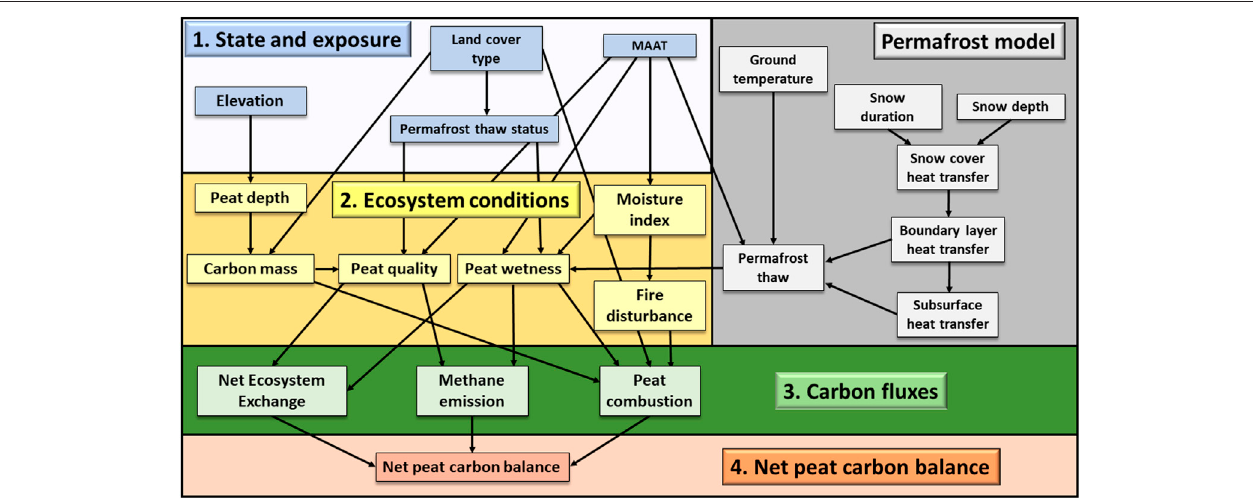
FIGURE 2 | General structure of in fl uence diagram of Bayesian belief network framework for the study area in the southern Hudson Bay Lowlands under current climate. Arrows connect parent nodes to child nodes and black bars indicate state (terminal parent nodes) or probability of in fl uence based on conditional probabilities (child